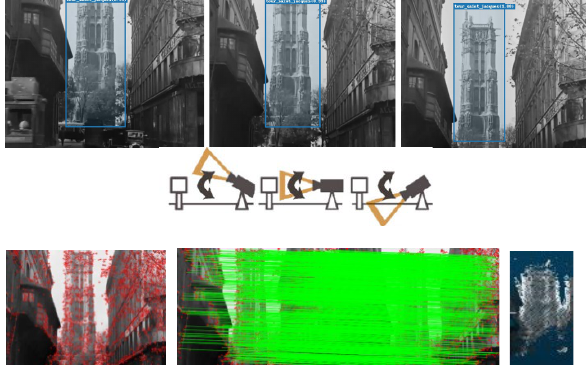
Figure 8. Results of the photogrammetric processing of the frames from the film footage “Études sur Paris” shot with tilting camera motion.